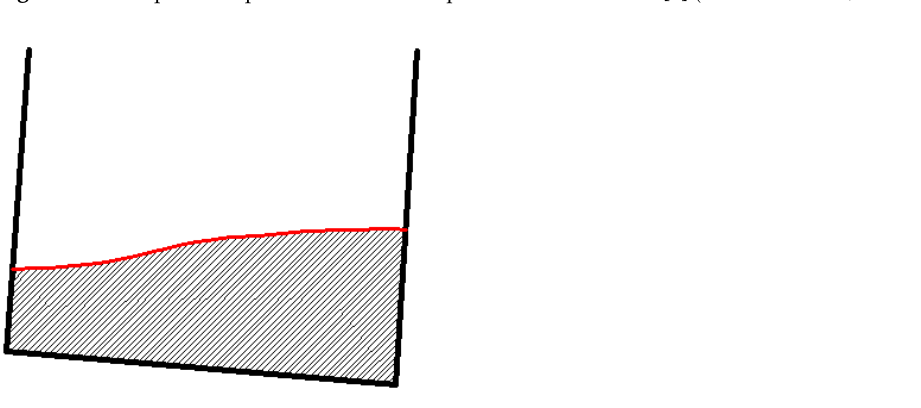
Figure 17. Flow pattern reproduced form the experiment of Chen et al. [3] ( ω = 0.95 rad/s, t = 11.57 s ) .